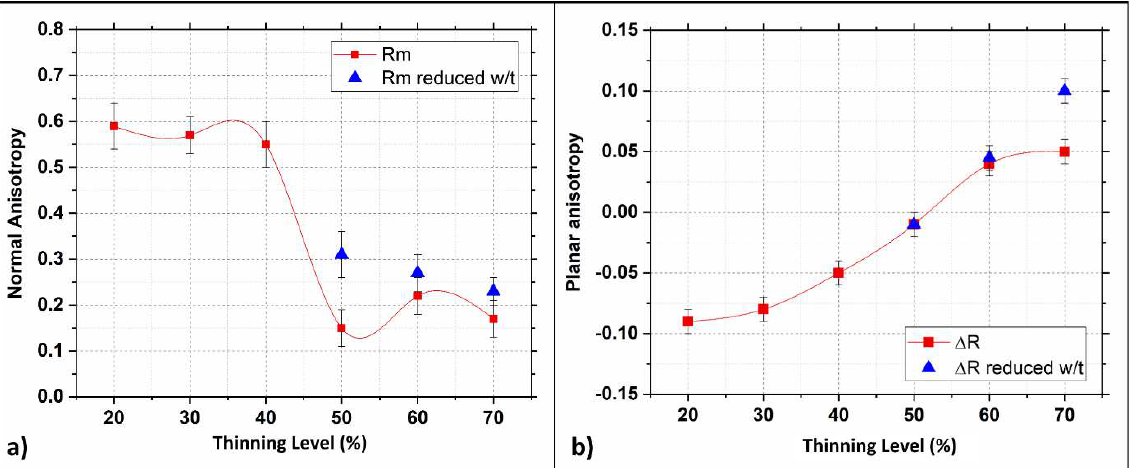
Figure 11. Anisotropy measured using Equations (1), (2) and (3): ( a ) Normal R and ( b ) planar